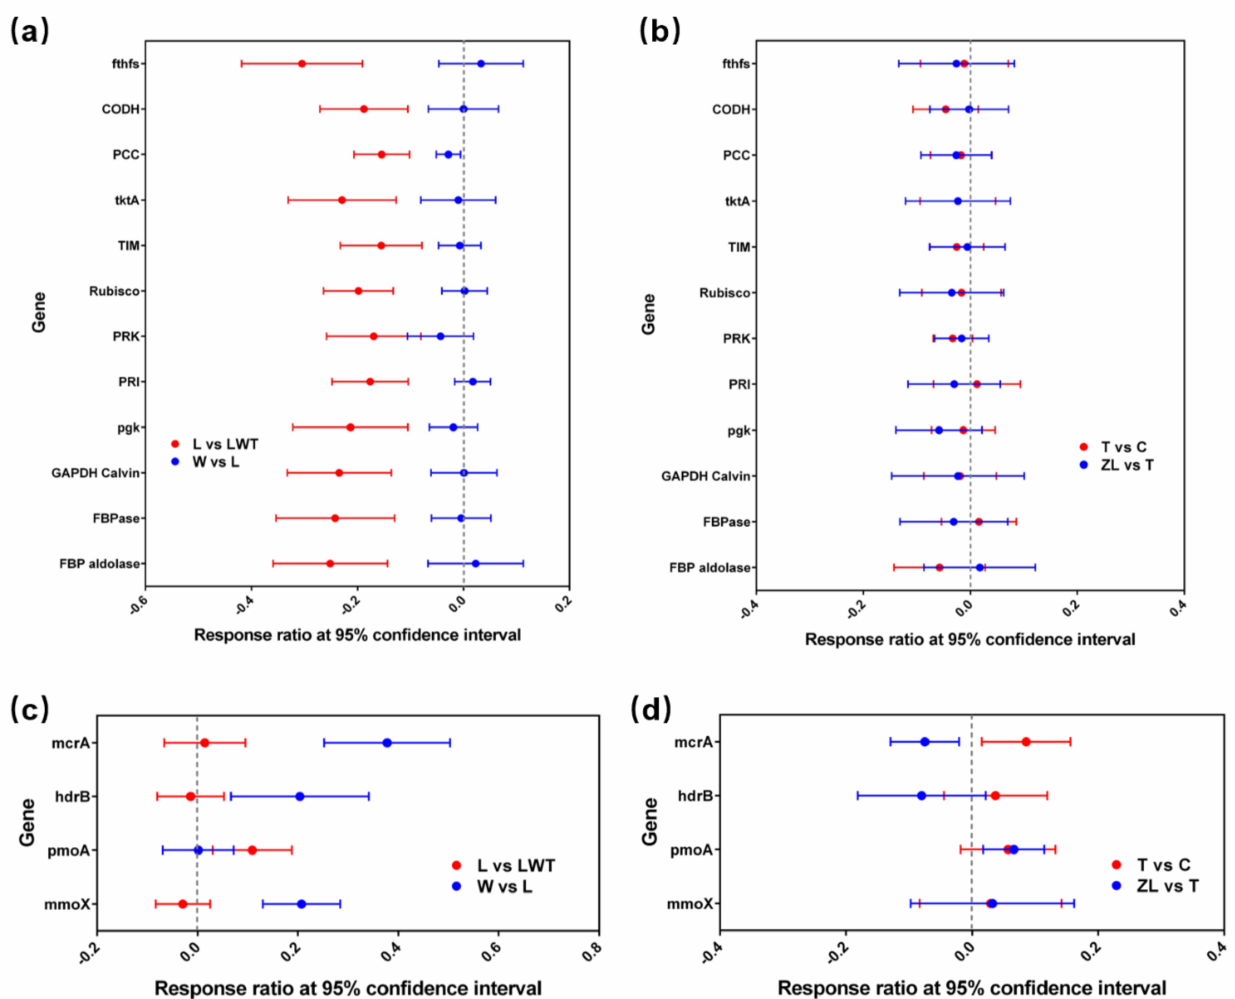
Figure 10. Response of C fixation and methane metabolism-related genes to degraded and restored/natural wetland sites according to GeoChip data. RRs of C fixation ( a ) and methane metabolism ( c ) genes are presented as the difference between lightly degraded and severely degraded Phragmites marsh sites (red symbols), and between restored and lightly degraded Phragmites marsh sites (blue symbols). RRs of C fixation ( b ) and methane metabolism ( d ) genes are presented as the difference between natural and degraded Carex marsh sites (red symbols), and between two natural Carex marsh sites (blue symbols). The RR is considered significant when the 95% confidence interval (presented as error bars) does not overlap with 0. The abbreviations present restored (W), lightly degraded (L), and severely degraded (LWT) Phragmites marsh sites, and the natural (T, ZL) and degraded (C) Carex marsh sites,